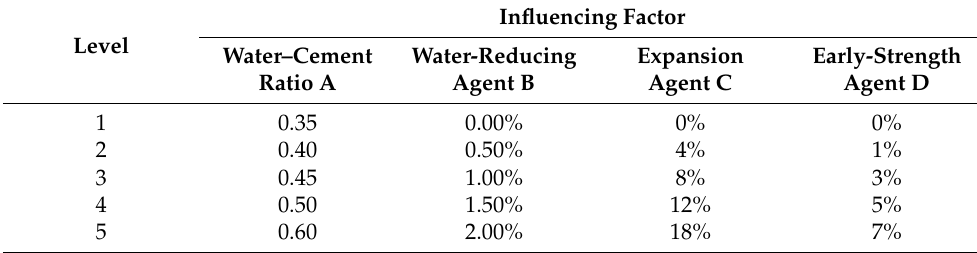
Table 1. Head design of orthogonal